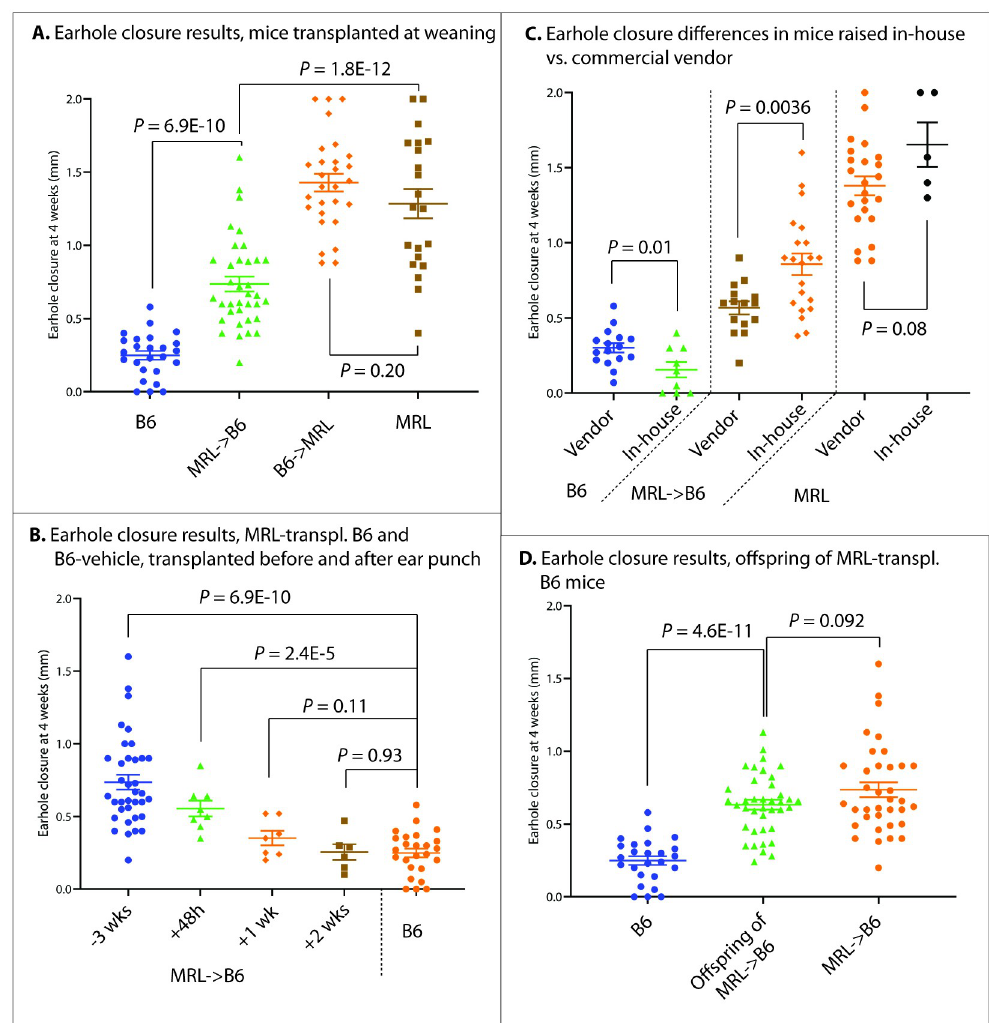
Fig 1. Mouse earhole closure results 4 weeks after a 2.0mm ear punch under various microbiome transplantation conditions.